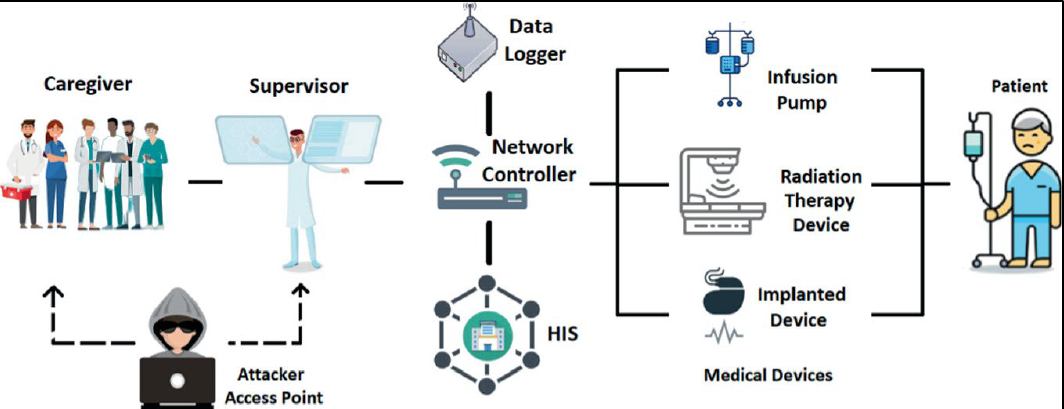
Figure 1. Integrated Clinical Environment (ICE).